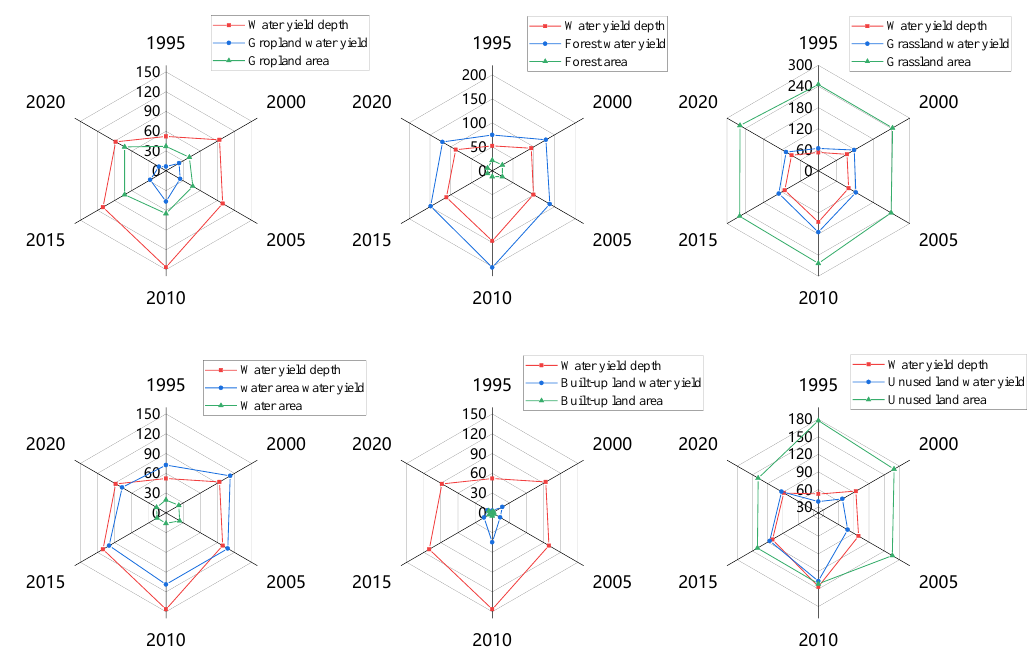
Figure 8. Linkage characteristics of land-use type water yield, type-area change, and average water yield depth